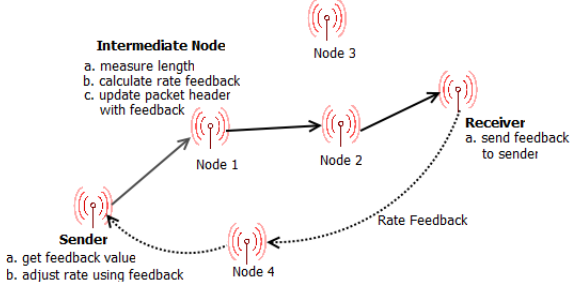
Fig. 1. Illustration of ERCM congestion control mechanism Lists of